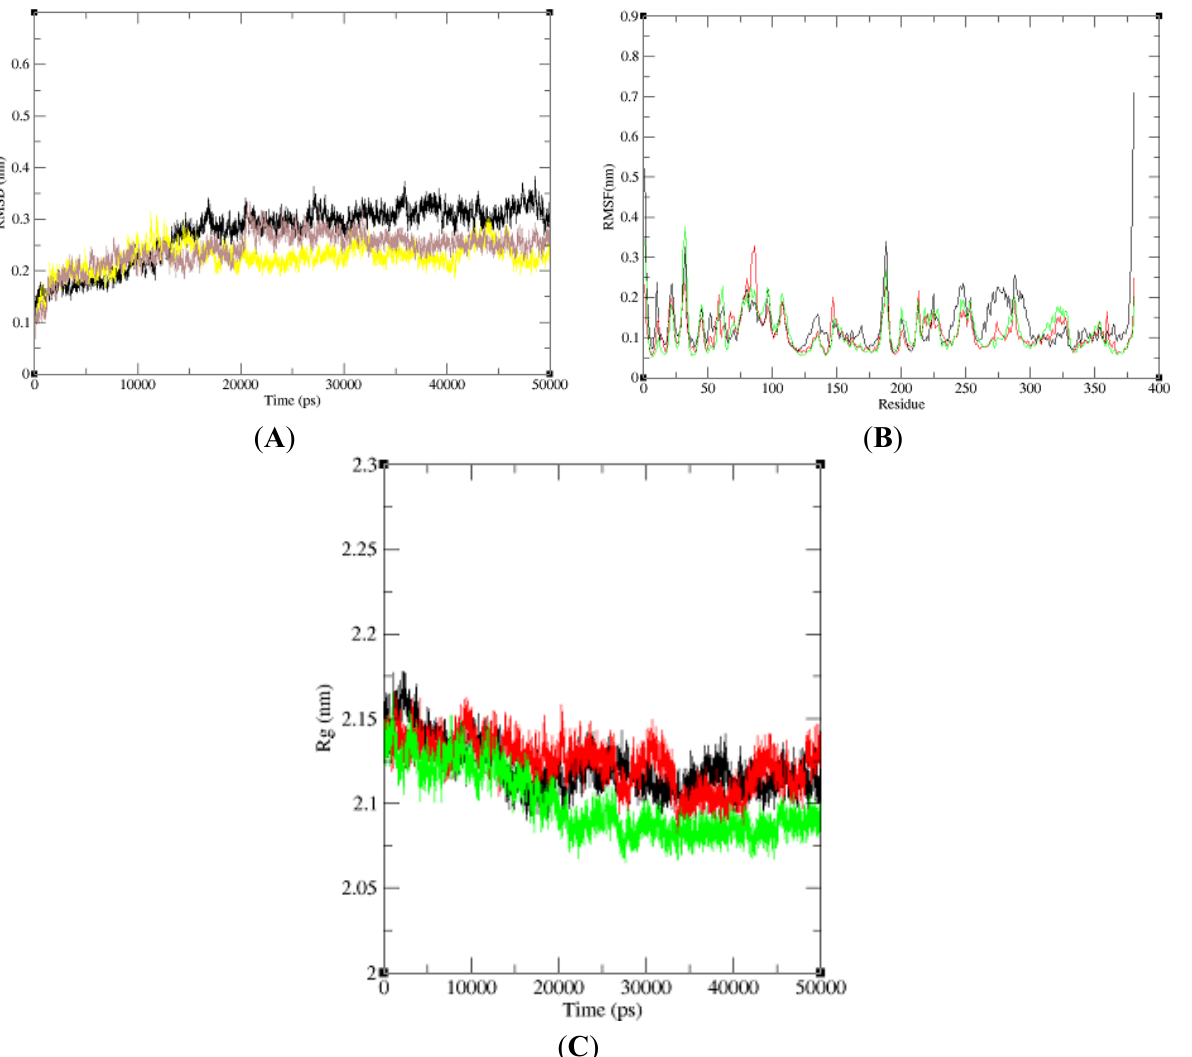
Figure 1. Dynamic changes of the NBD upon mutations. ( A ) Root mean square deviations (RMSD) of NBD (black), K71L (yellow) and T204V (brown); ( B ) Backbone atomic fluctuations (RMSF) of NBD (black), K71L (red) and T204V (green); ( C ) Radius gyration of NBD (black), K71L (red) and T204V